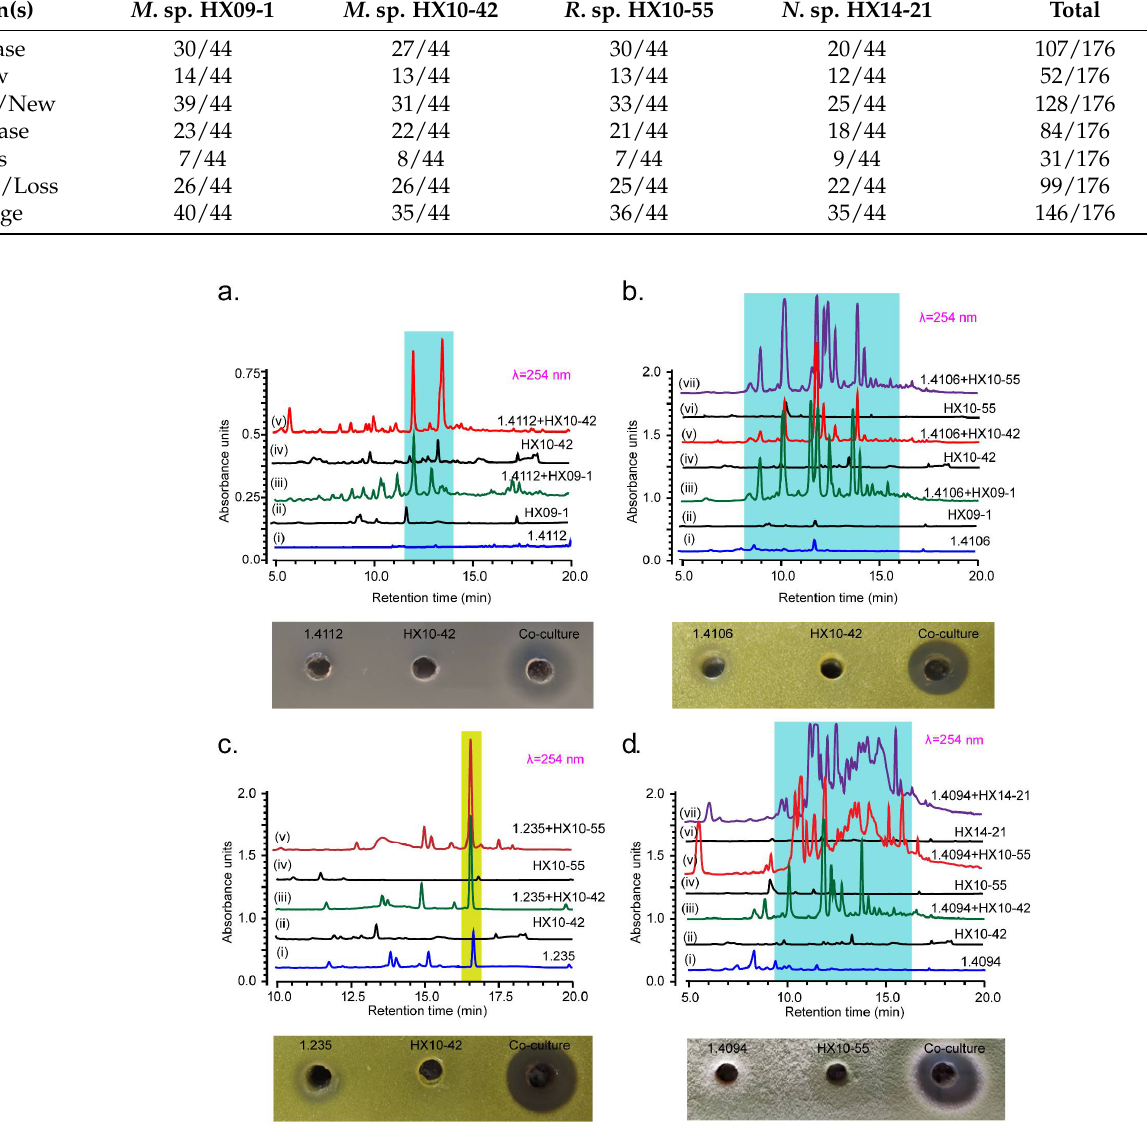
Figure 3. HPLC analysis of changes in SM spectra and agar-well diffusion test of emerging antimicrobial activity in the co-cultures compared to the pure cultures. ( a ) S . sp. FXJ1.4112 co-cultured with MACB produced “new” metabolites (blue shadowed) and strong antibacterial activity against E . coli ; ( b ) S . sp. FXJ1.4106 co-cultured with MACB produced a series of “new” metabolites (blue shadowed) and strong antibacterial activity against M . luteus; ( c ) S . sp. FXJ1.235 co-cultured with MACB produced a higher yield of the original metabolite (yellow shadowed; the integral area of HPLC peaks was over twice that of control) and strong antibacterial activity against M . luteus ; ( d ) FXJ1.4094 co-cultured with MACB pro- duced a series of “new” metabolites (blue shadowed) and strong antifungal activity against T . viride . Antimicrobial activity was estimated by measuring the diameter of the inhibition zones: positive (7 mm [hole diameter] < diameter ≤ 9 mm) and strongly positive (diameter > 9 mm).